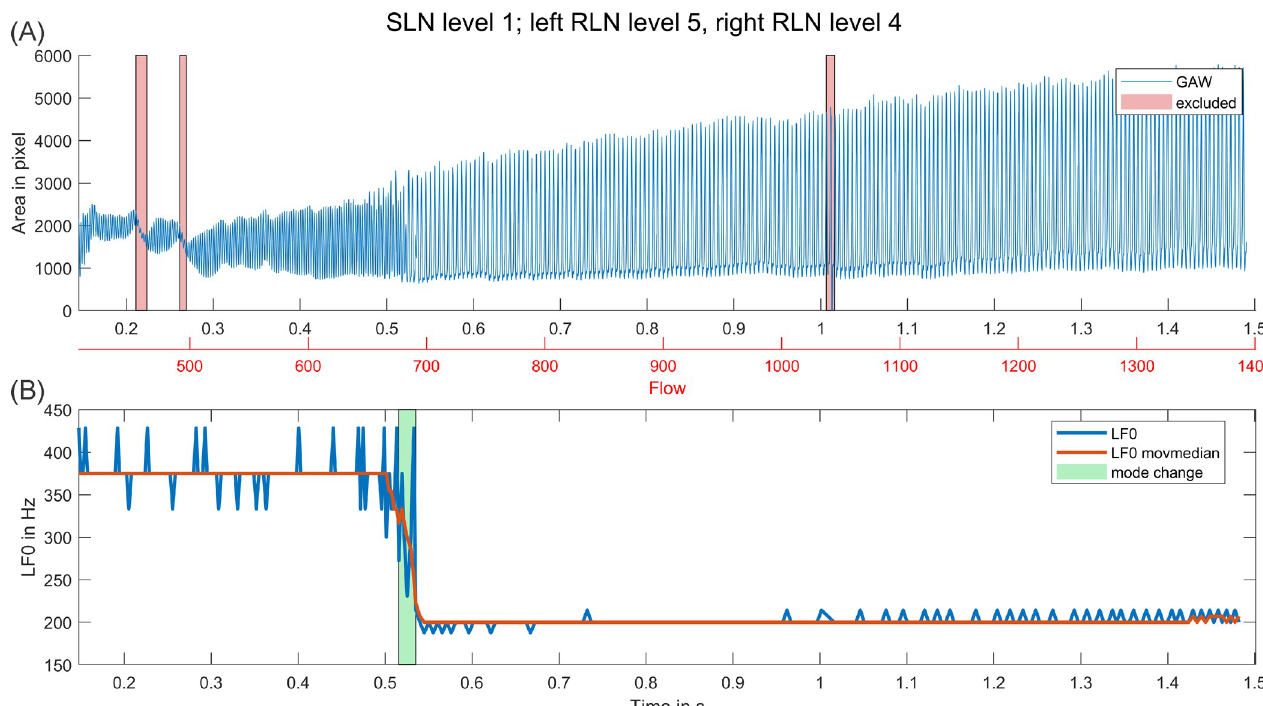
Fig 4. Example for a typical mode change. (A) GAW over period of stimulation with increasing flow, excluded sections due to bad cycle detection / camera malfunction are marked. (B) LF0 and median LF0 (10 cycles) over same period with marked mode change at 0.52 s.